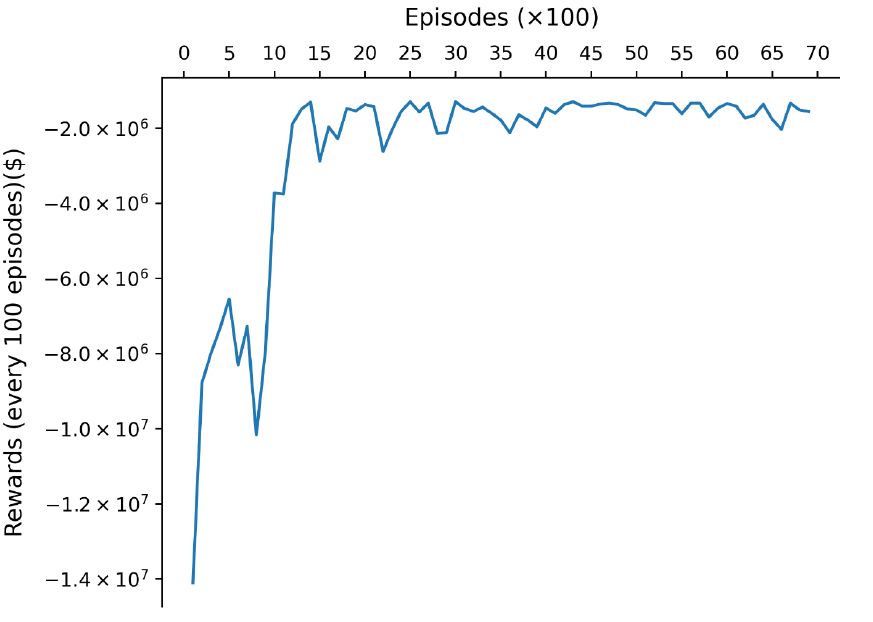
Figure 2. Episodic average reward in every 100 episodes in a scenario with 10